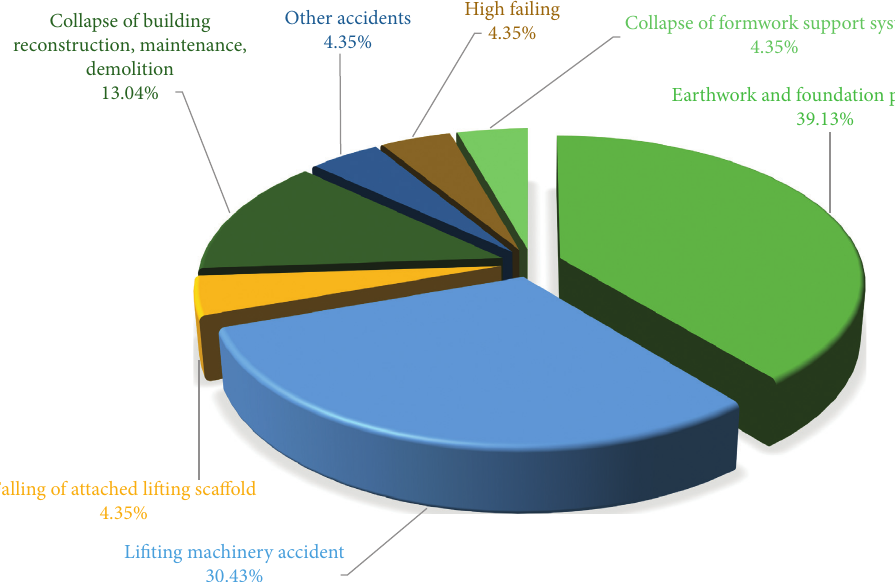
Figure 4: Major and above accidents in safety production of housing and municipal projects in China in